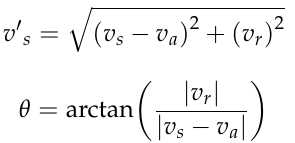
Figure 2. Geometry of the GBSAR and moving target after relative speed transformation. Equations (6) and (7) are relative speed transformation, v (cid:48) s is the value of relative speed, θ shows its direction. According to the aforementioned geometry and motion assumptions, the v (cid:48) s and θ are